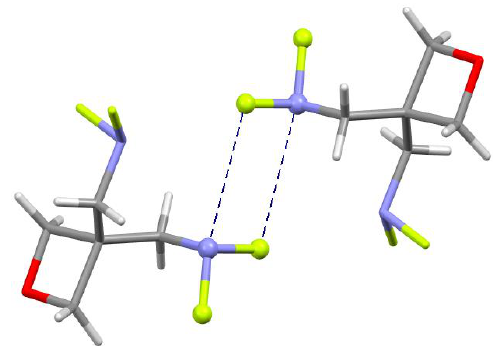
Figure 14. Fragment of crystal structure of 3,3-bis(difluoroaminomethyl)oxetane. Colors: red = oxygen, blue = nitrogen, green = fluorine, white = hydrogen, gray = carbon. Dashed lines show N---F σ-hole